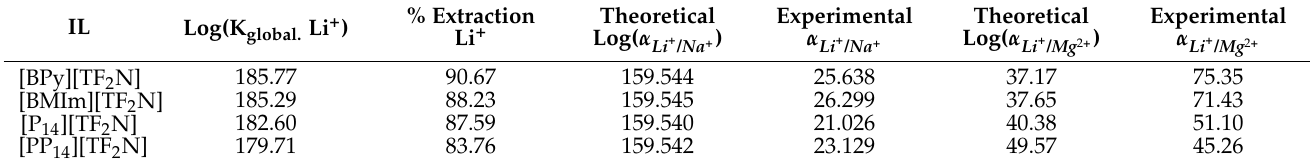
Table 2. Theoretical global extraction constants (K global ) and selectivity validation using experimental data [22] for different ILs when TBP is used.